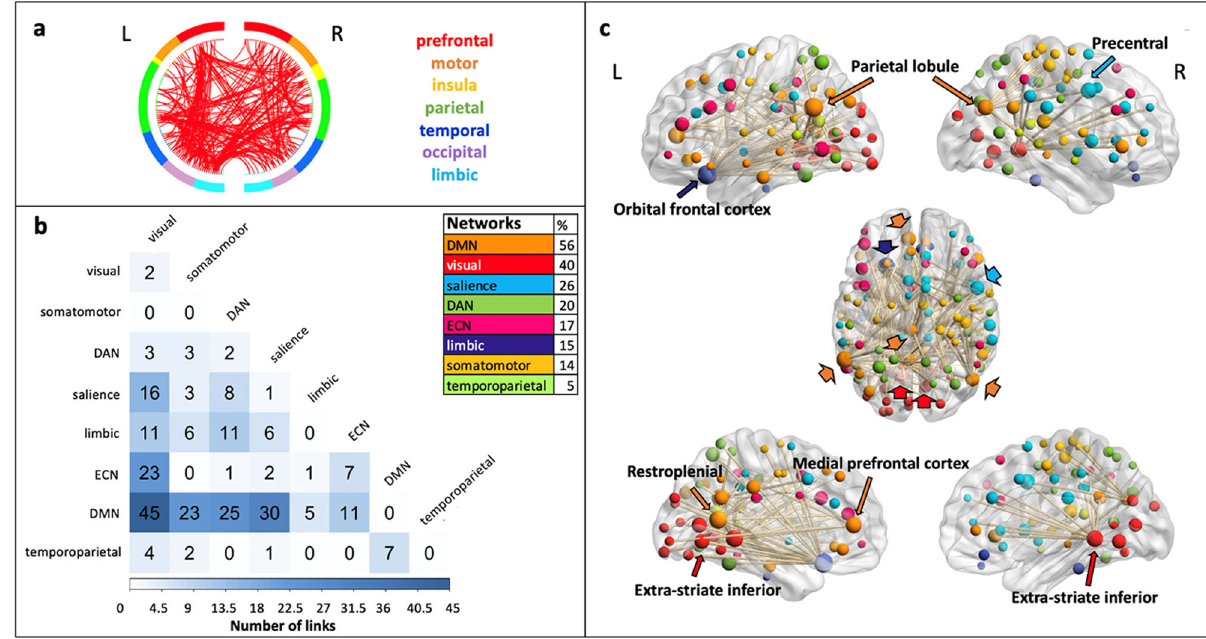
Fig. 5 Functional anatomy of the CPM model predicting the switching PolyFT component. The functional connectivity patterns of the positive model network predicting switching are described. a The circular graph represents the distribution of links within and between brain regions in the left (L) and right (R) hemispheres. Brain regions are color-coded. For visualization purposes, we used a nodal degree threshold of k > 10. The lines in red represent the links connecting the ROIs. b We examined the distribution of the links across intrinsic functional networks based on Schaefer ’ s atlas 103 . The correlation matrix represents the number of links within the model network connecting within and between eight intrinsic brain networks (total of links = 259). At the upper right side, a table with the percentage of links connecting nodes that belong to these functional networks is shown. This percentage considers all connections to the regions of a given functional network in relation to the total number of connections in the model network (i.e., 259 links). c The nodes (total of nodes = 122) and links of the model network are superimposed on a volume rendering of the brain. From top to bottom, a lateral, dorsal, and medial views for the left and right hemispheres are shown. The color of the nodes represents the functional network they belong to, using a color code presented in b . The size of the nodes is proportional to their degree. Thicker links are connecting the highest degree nodes to the rest of the brain. The color code arrows indicate the highest degree nodes and the brain region in which they are localized. For visualization purposes, nodes with degree k = 0 are not displayed. ECN executive control network, DMN default mode network, DAN dorsal attention